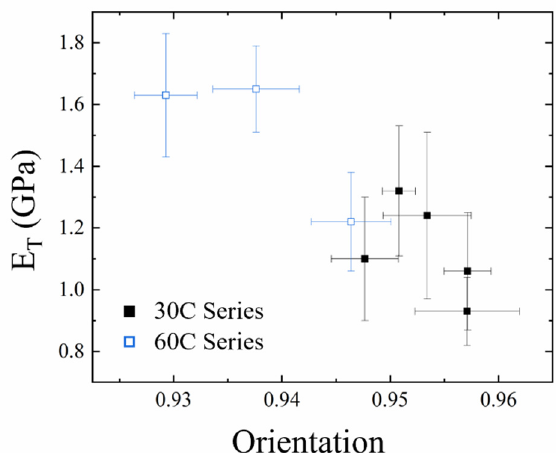
Figure 7. Relationship between E T and orientation for the WFs measured in this study. The error bars represent the standard deviation.